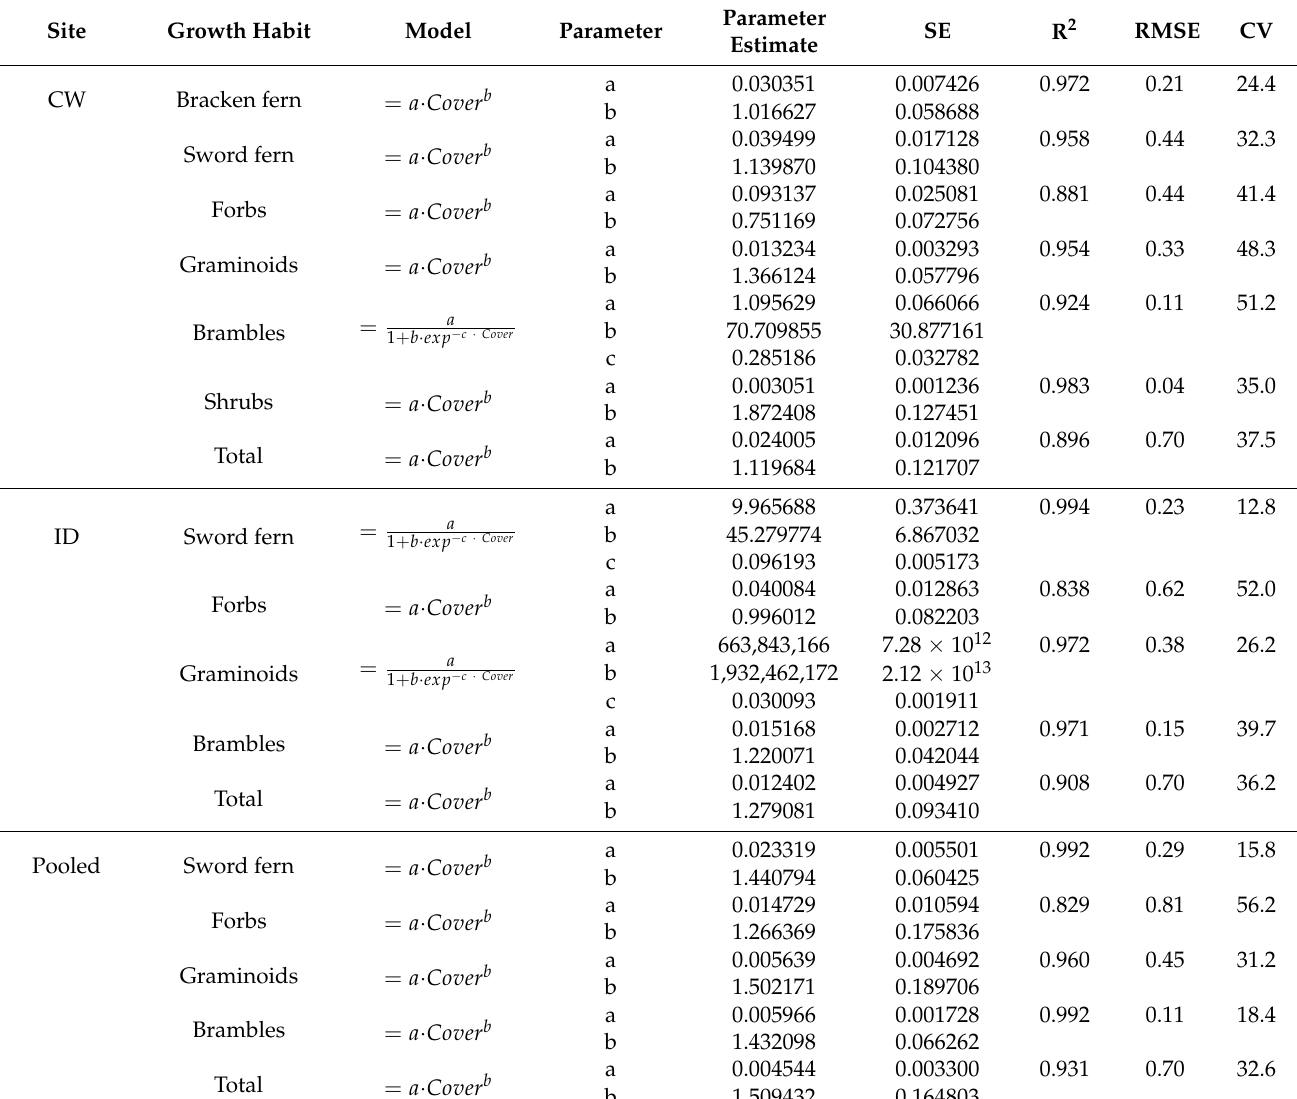
Table 3. Parameter estimates and fit statistics of the selected functions to estimate biomass using cover for each growth habit of early-seral vegetation growing in Western